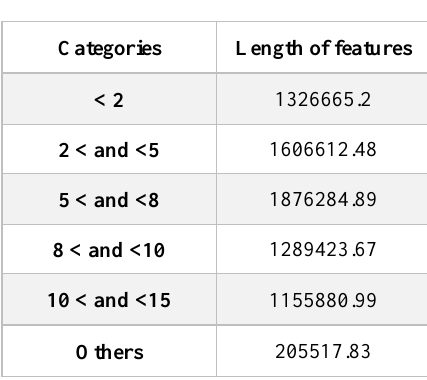
Table 9: The Results of Geometric